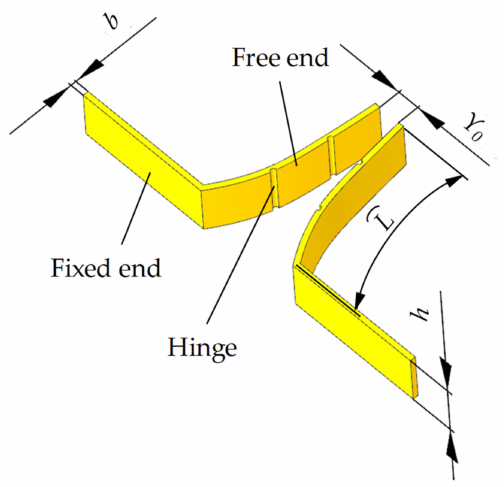
Figure 1. Structure of the flexible valve.